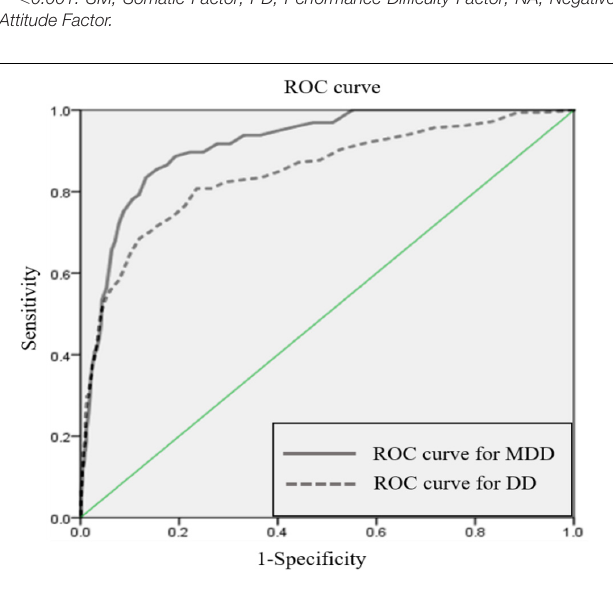
FIGURE 2 | ROC curve for MDD and